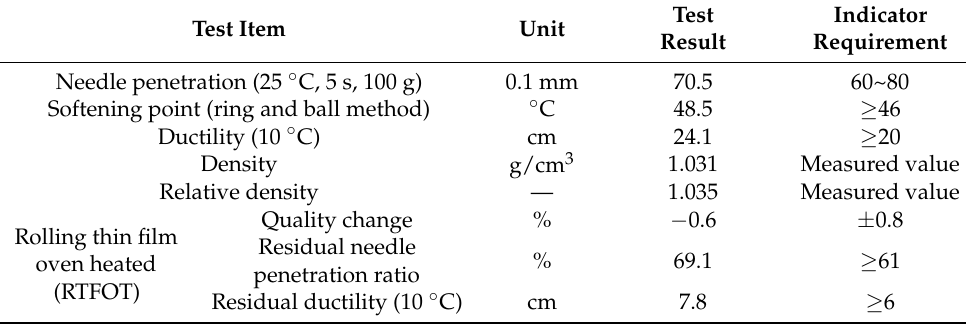
Table 7. Technical indicator requirements and test results of 70# matrix